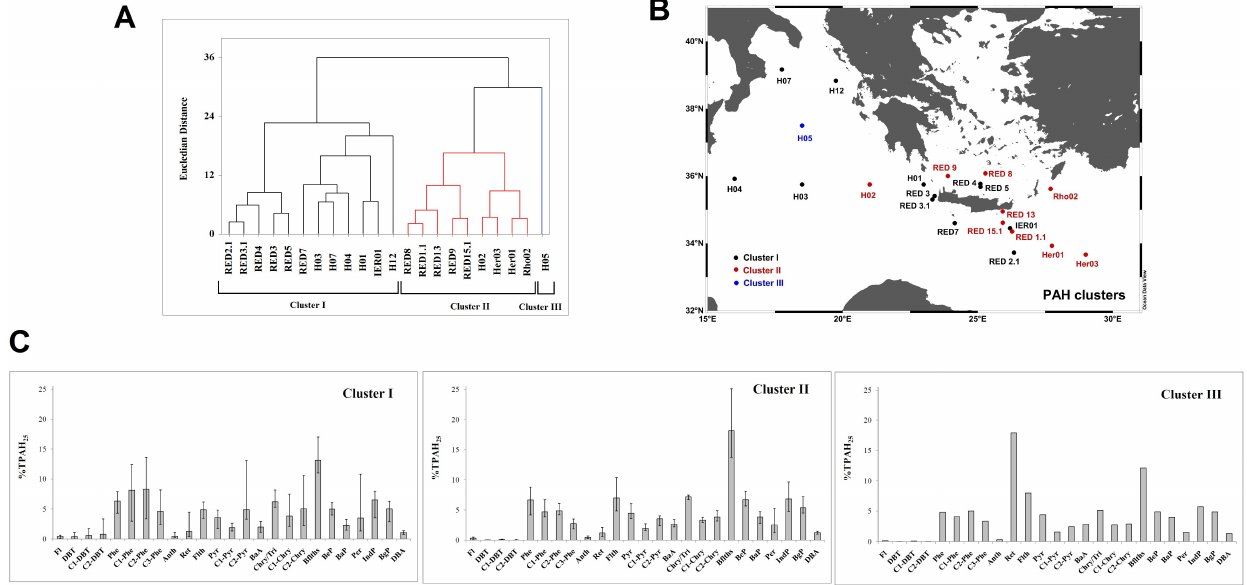
Fig. 8. Hierarchical diagram obtained from cluster analysis of stations with regard to PAH profile (A) , clustered stations (B) and molecular profile for each returning cluster (C) . Individual compound abundances are normalized as percentage of TPAH 25 and presented along with min–max deviation lines. PAH abbreviations are presented in Fig.